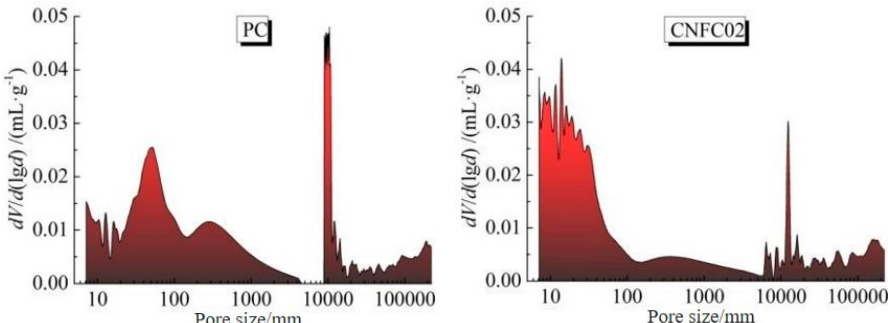
Figure 14. Differential curves of typical pore size distribution of samples.